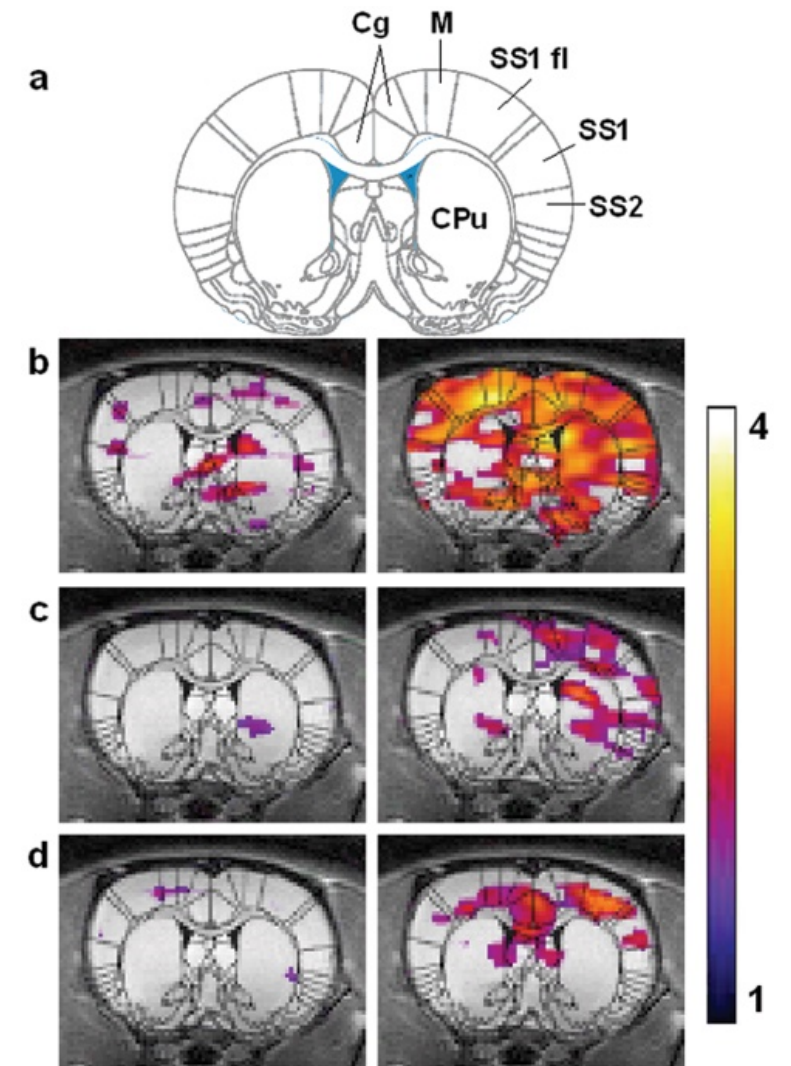
Figure 30. The HXe signal is shown as a false colour overlay on the corresponding 1 mm thick coronal proton reference image taken from the same animal. The left panel shows HXe signal intensity during baseline and the right panel shows HXe signal intensity after injection of capsaicin 20 uL (3 mg/mL) into the right forepaw. Colour scale represents SNR and only signal with SNR above 2 are shown. Superimposition of a rat brain atlas demarcates specific areas of the brain: cingulate cortex (Cg), motor cortex (M), primary somatosensory cortex and SS1 forelimb region (SS1 and SS1 fl), secondary samatosensory cortex (SS2), and striatum (CPu). Reprinted with permission from Mazzanti, et al. ( PLoS ONE 2011, ref. [121]).